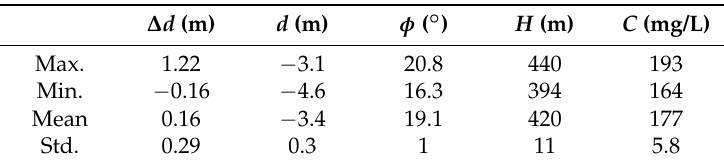
Table 3. Statistical parameters of the five-type data used in the modeling. ∆ d : depth bias; d : water depth; φ : beam scanning angle; H : sensor height; C : SSC.